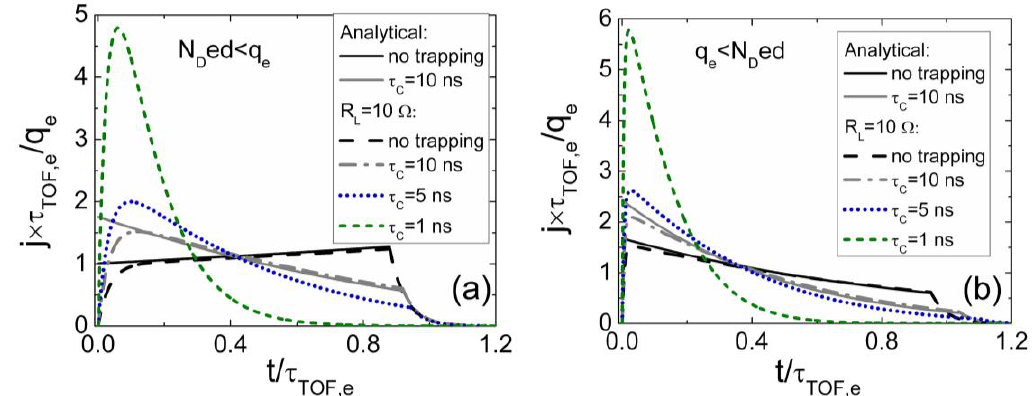
Figure 3. Transients of the normalized current density j ×  ( a ) and small ( b ) monopolar charge drift, simulated using different values of the carrier capture lifetime  . Solid curves are calculated using the analytical expressions, while the C intermittent curves are obtained including the RC of a signal recording circuit.